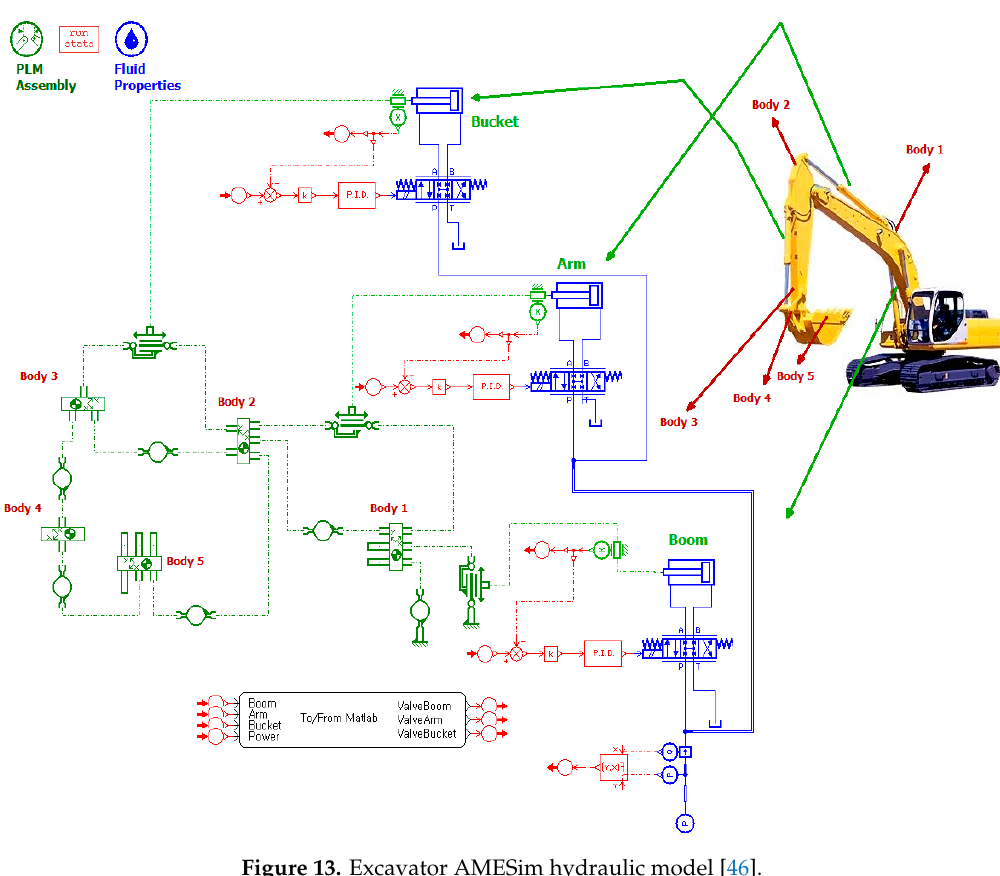
Figure 12. Co-simulation environment.